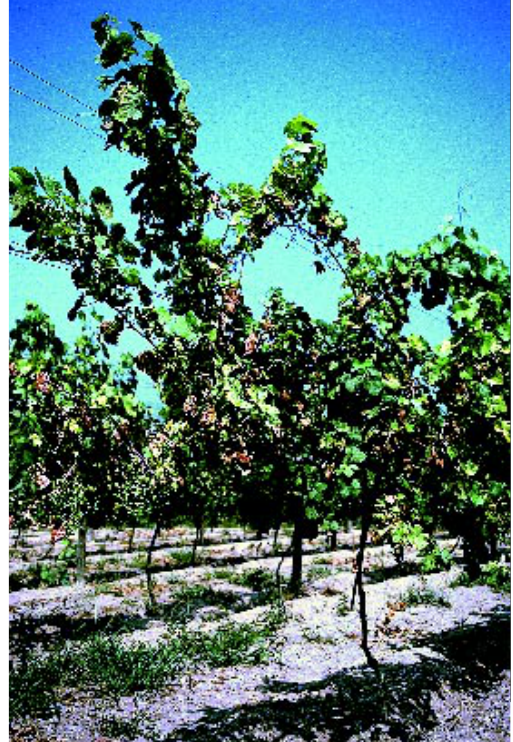
Fig. 4. Young plants with grapevine decline show- ing stunted growth and chlorotic foliage.